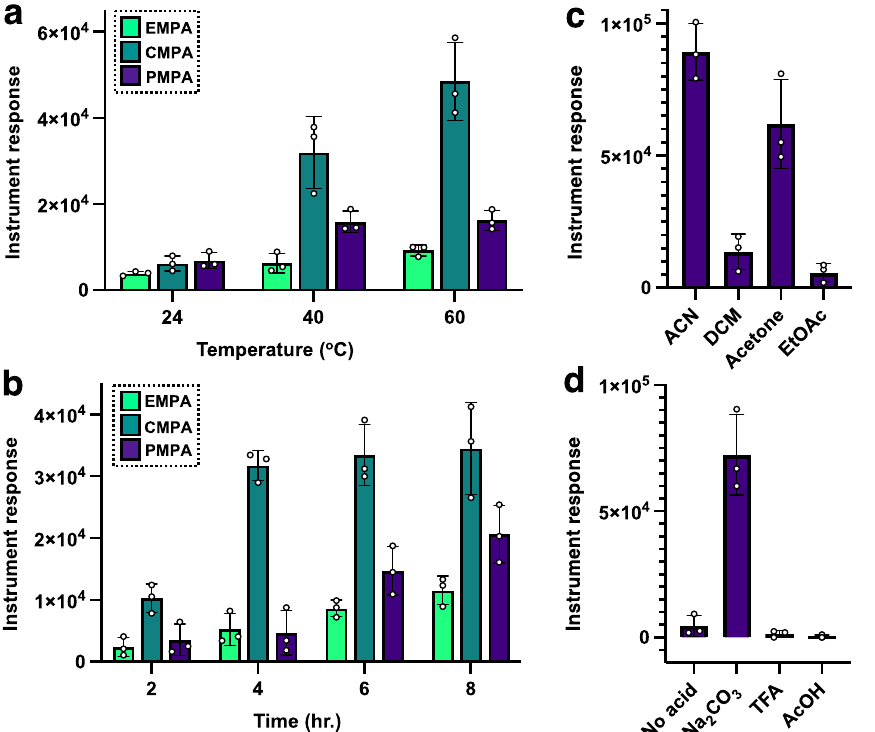
Figure 3. Derivatization of phosphonic acids with p -methoxybenzyl trichloroacetimidate: Optimization reactions, average (n = 3) peak areas (± the standard deviation) for the p -methoxybenzylated phosphonic acid after the acid (0.8 μmol, [100 ppm]) is treated with the trichloroacetimidate (200 μL, excess) in acetonitrile (ACN, 1 mL), ( a ) the effect of temperature on the derivatization yielding similar results for mild heating (40 °C) and heating to 60 °C for 4 h; ( b ) time for the reaction where a maximum accumulation of the three p -methoxybenzylated acids can be observed at ~ 4 h; ( c ) studies on just PMPA reveal that ACN and acetone